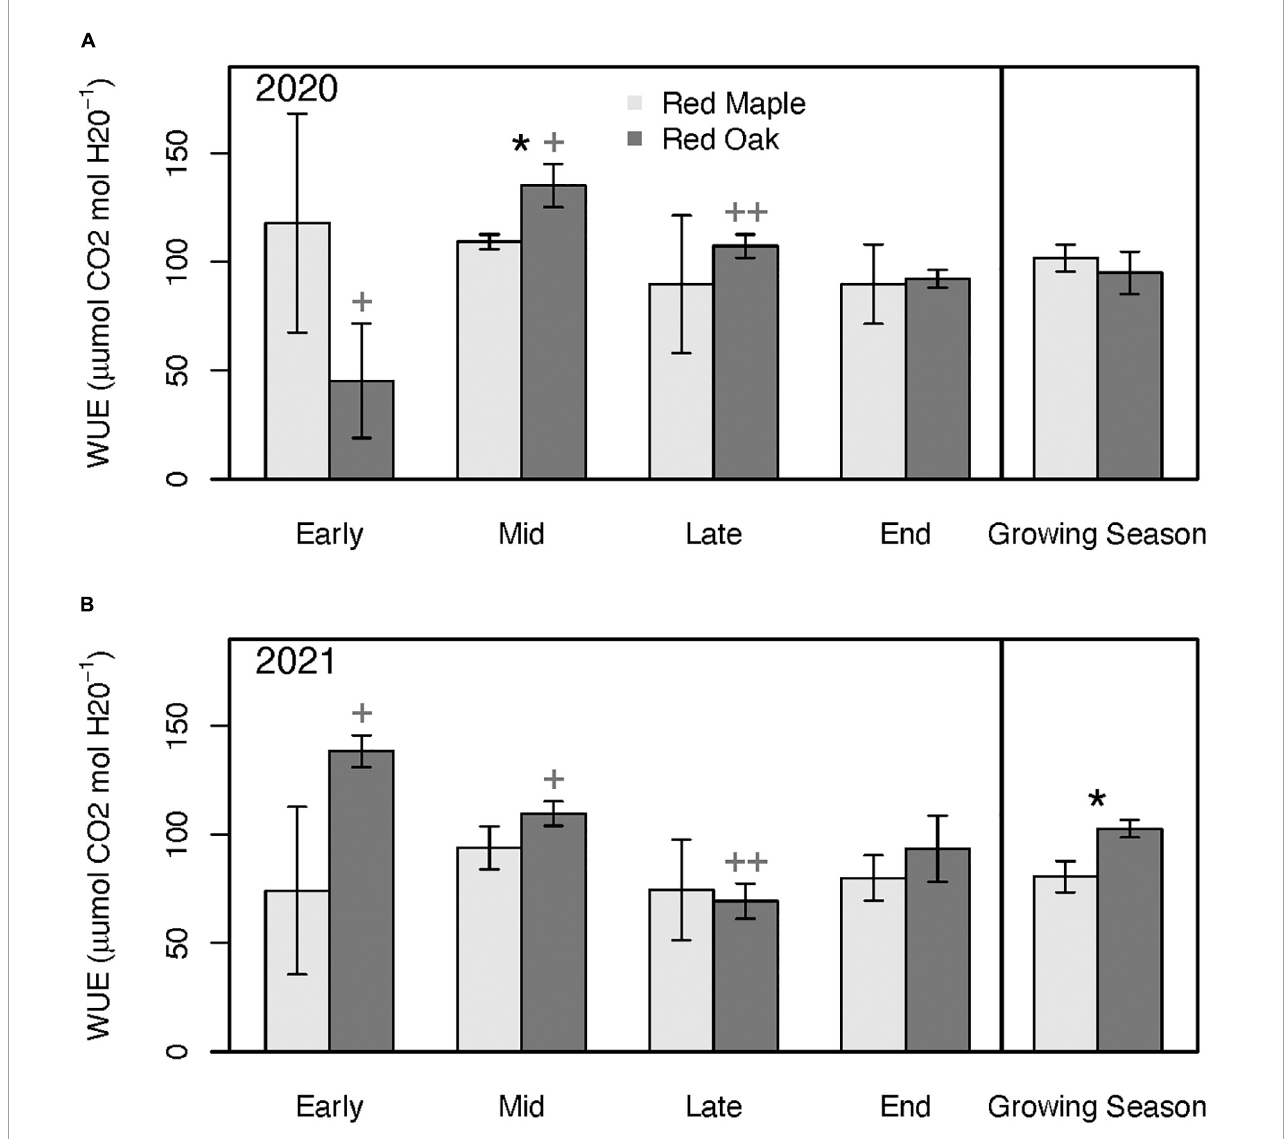
FIGURE7 Leaf-level water-use efficiency (WUE) across the growing season and for the mean across the growing season during 2020 (i.e., year with oak-defoliating frost) (A) and 2021 (i.e., year without defoliating frost) (B) for red maple and red oak leaves. Asterisks denote differences between species within a year at * p < 0.1. Plus signs denote differences between years for oak trees at ++ p < 0.05 and + p < 0.1. There were no significant differences between years for the maple trees. See Supplementary Tables 3A, B for summary